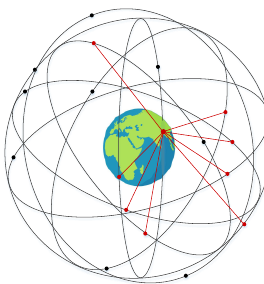
Figure 1. Illustration of a 24 GPS satellite constellation in motion relative to the Earth’s rotation (Source: Wikipedia [5]).